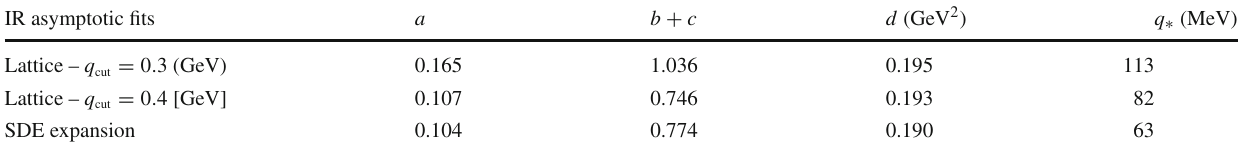
Table 2 Fitting parameters of Eq. (3.12) for different values of the cut- off q cut consideredinthefittingprocessofthelatticedatawith β = 1 . 63. In the last line, we show the fitting parameters of the SDE asymptotic limit, given by Eq. (3.12), which was obtained by expanding the result